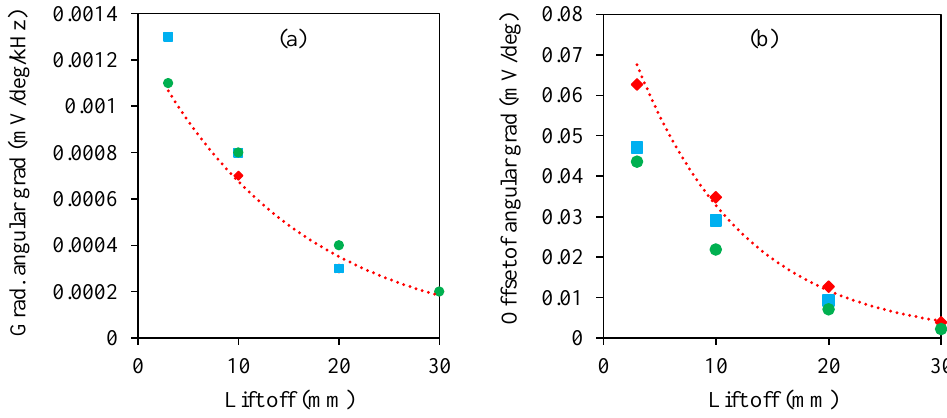
Figure 9. ( a ) Gradient and ( b ) offset of the frequency dependence of the angular gradient at high frequencies, Figure 8, as a function of lift-off for a copper (red diamonds), brass (green dots), and aluminium (blue squares) plate. The red dotted curve is an exponential fit to the copper